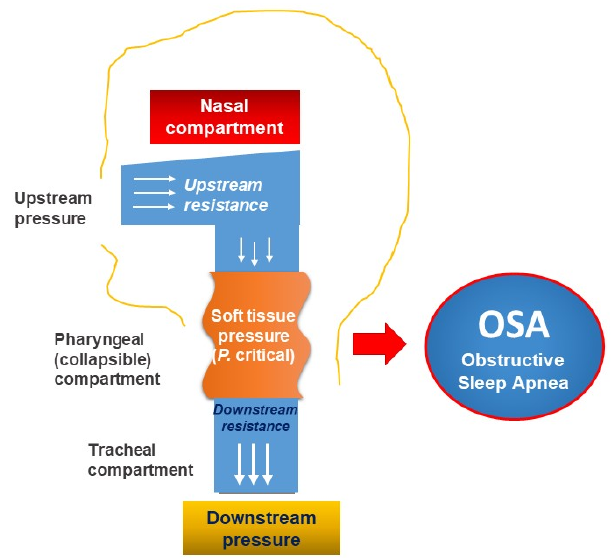
Figure 2. Mechanism of obstructive sleep apnea (OSA) related to pharynx collapse due to the increase of upstream and downstream pressure and resistance.